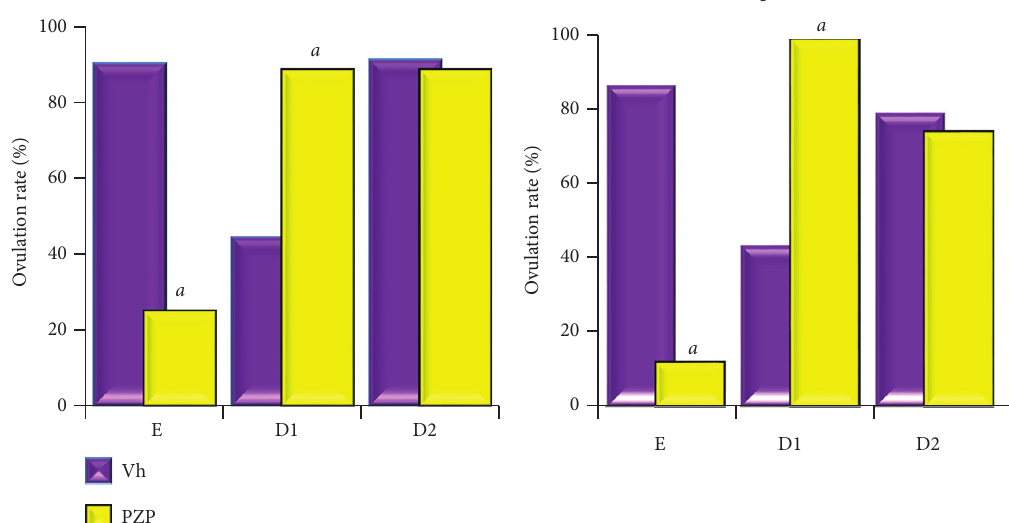
Figure 4: The e ff ects of vehicle (Vh) or pirenzepine (PZP) microinjected in the left or right side of the POA-AHA region on ovulation. The ovulation rate (number of ovulating animals over total number of the treatment group) of rats microinjected with vehicle (Vh) or pirenzepine (PZP) in the left or right POA-AHA at 13:00 h of the oestrous (E), dioestrous-1 (D1), or dioestrous-2 (D2). a p < 0 05 versus the respective Vh group (chi-square